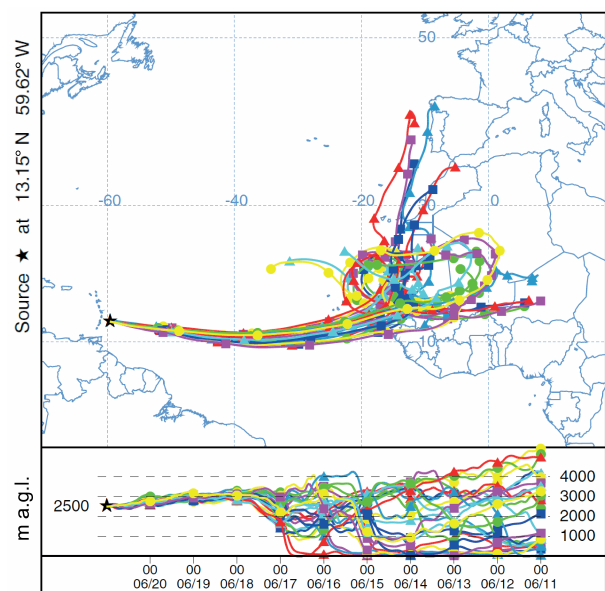
Figure 8. Ensemble of 10-day HYSPLIT backward trajectories for 21 June 2014, 00:00UTC, arriving at 2500m over Barbados.